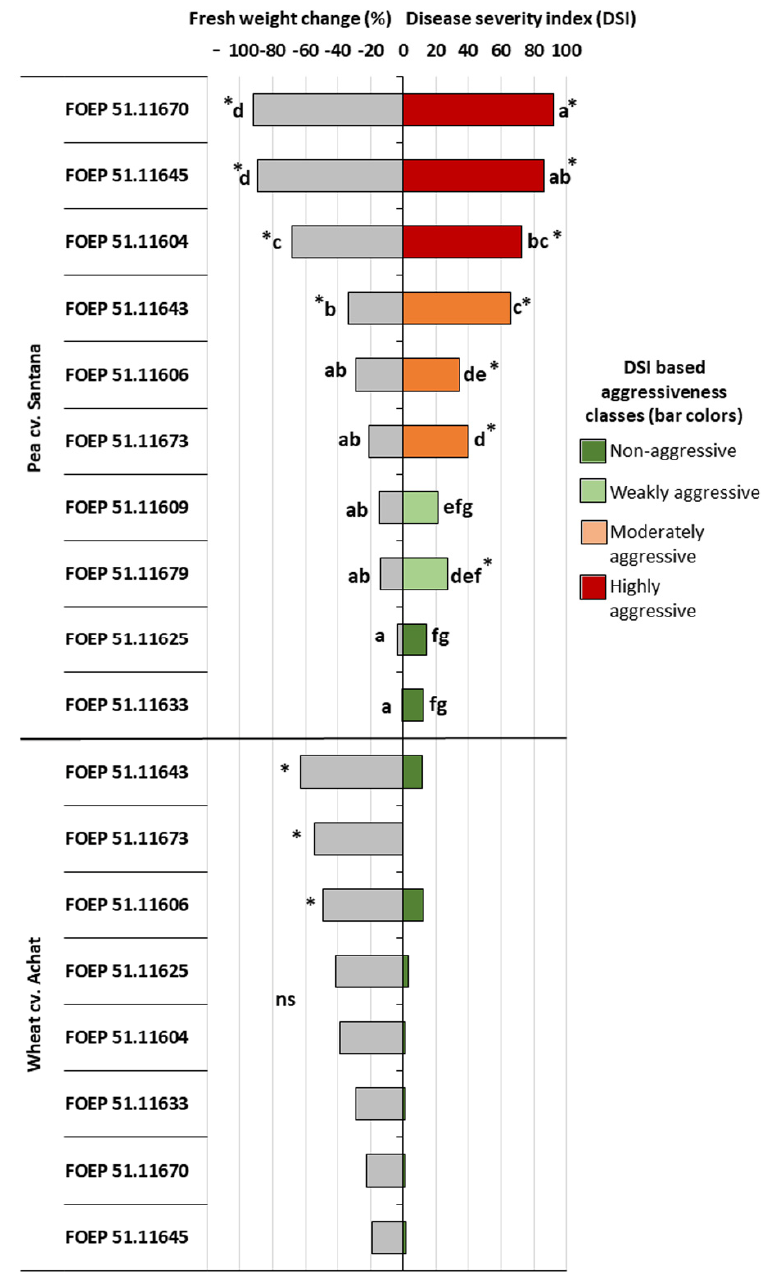
Figure 2. Effects of D. pinodella isolates on pea and wheat root rot disease severity ( right ) and plant fresh weight ( left ). The isolate effects on fresh weight are expressed as percentage change relative to the non-inoculated control. Root rot disease severity is expressed as isolate disease severity index (DSI) and corresponds to different bar colors, where DSI = 0–15 non-aggressive; DSI = 16–30 weakly aggressive; DSI = 31–70 moderately aggressive; DSI = 71–100 highly aggressive isolate. Different letters indicate significant differences among isolates (ns = non-significant). Asterisks next to the bars (*) indicate significant difference from the non-inoculated control plants (Tukey multiple comparisons test ( p < 0.05)). Pea fresh weight data were Log 10 transformed prior to analysis. Data presented are means of three replicate pots.